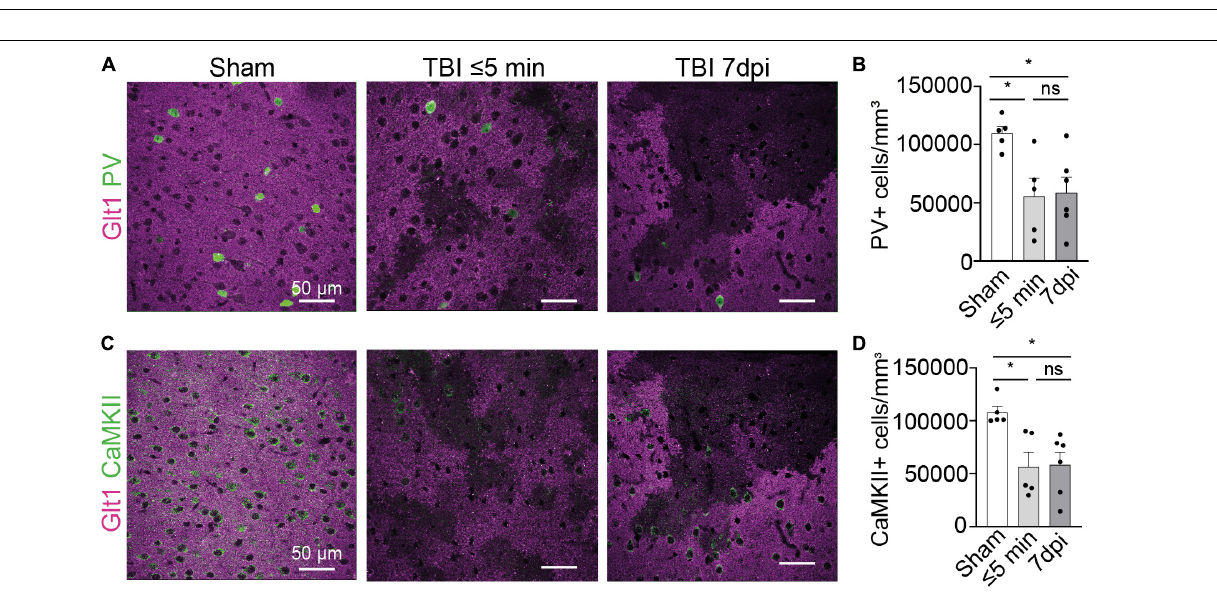
FIGURE 2 | Interneuron and glutamatergic densities changed in areas of atypical astrocytes. (A) In atypical areas, expression of the interneuron protein parvalbumin (PV) was reduced. Panel on the left show Sham, panel in the center show TBI ≤ 5 min and panel on the right show TBI 7 dpi (Magenta: Glt1, Green: PV). (B) Quantification of PV cell densities (cell/mm 3 ) in atypical areas and was plotted per animal and showed on average a reduction of half on. (Sham: 10,956 ± 618.4, n = 5; ≤ 5 min: 5,578 ± 1,541, n = 5; 7 dpi: 5,716 ± 1,579, n = 6). One-way ANOVA: significant, p -value = 0.0269. Post-hoc analysis (TukeyHSD): Sham vs. ≤ 5 min: p < 0.05; Sham vs. 7 dpi p < 0.05; ≤ 5 min vs. 7 dpi p < 0.9971. (C) In atypical areas, expression of the glutamatergic protein CamKII was reduced. Panel on the left show Sham, panel in the center show TBI ≤ 5 min and panel on the right show TBI 7 dpi (Magenta: Glt1, Green: PV). (D) Quantification of CamKII cell densities (cell/mm 3 ) in atypical areas was plotted per animal and showed on average a reduction of half. (Sham: 107,854 ± 5,644, n = 5; ≤ 5 min: 56,743 ± 13,383, n = 5; 7 dpi: 64,131 ± 11,321, n = 6). One-way ANOVA: significant, p -value = 0.0125. Post-hoc analysis (Tukey HSD): Sham vs. ≤ 5 min: p < 0.05; Sham vs. 7 dpi p < 0.05; ≤ 5 min vs. 7 dpi p < 0.8773. * p -value ≤